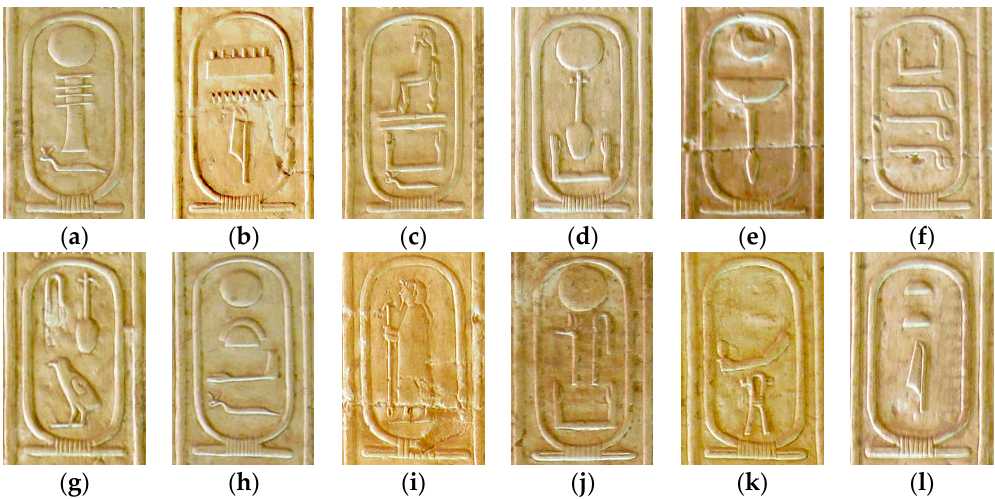
Figure 4. A set of cartouches from the Abydos King List.